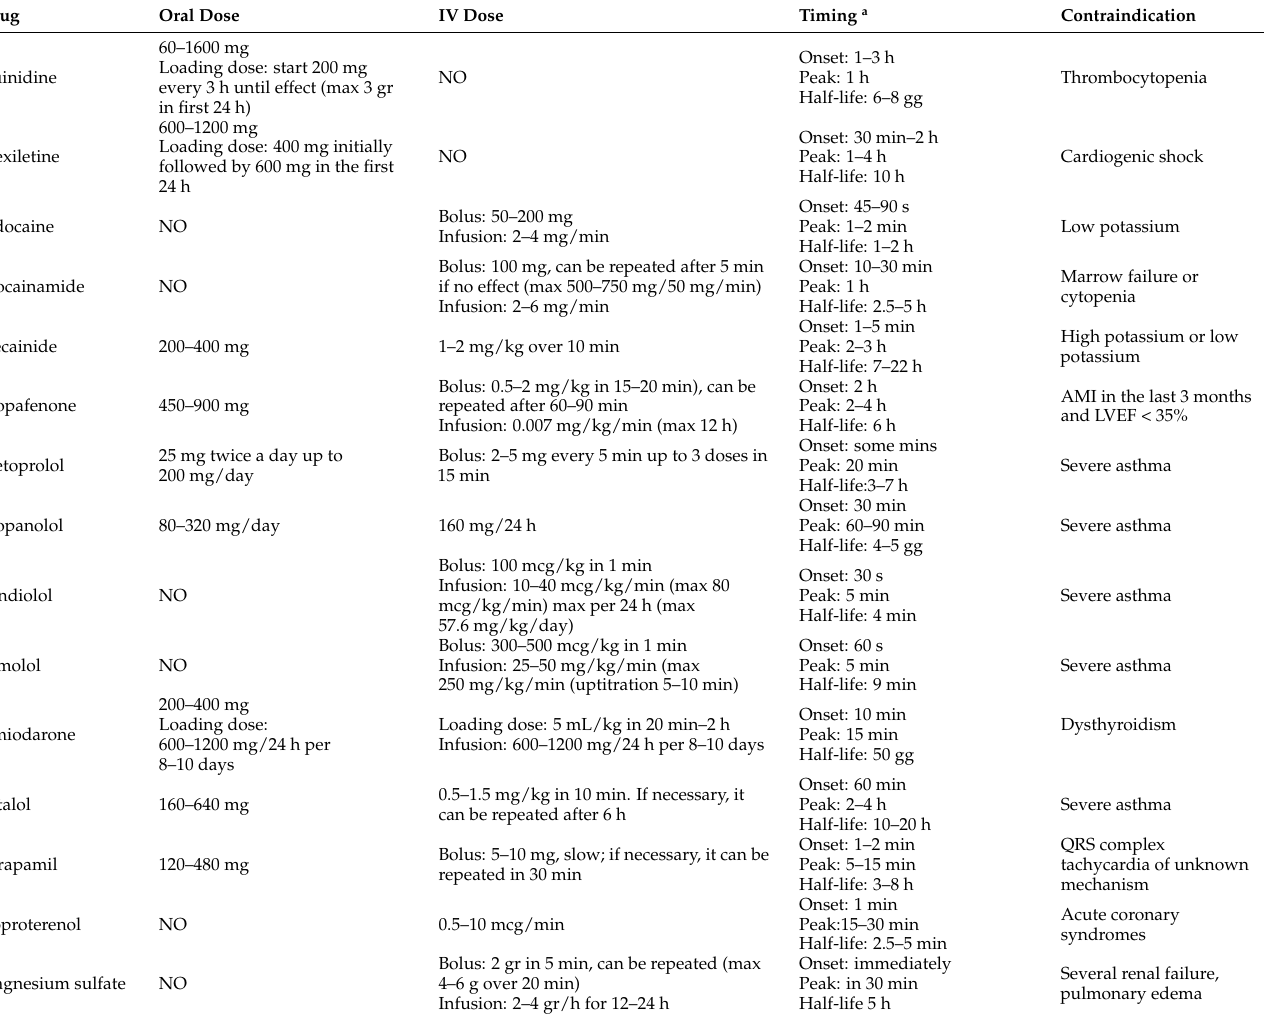
Table 2. Most used medications in ES. a Timing is based on intravenous (IV) dose; if not present, it is based on oral dose, Left ventricular ejection fraction